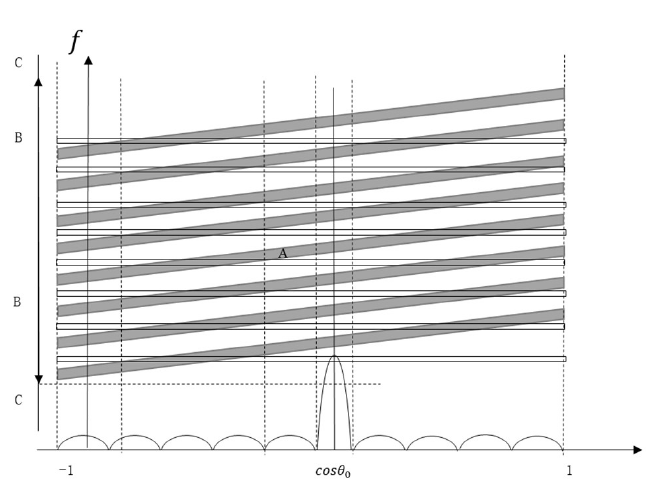
Figure 3. Reverberation zones for a PTFM waveform. Zone A is the grey striped band, The zone in the middle of zone A is zone B.